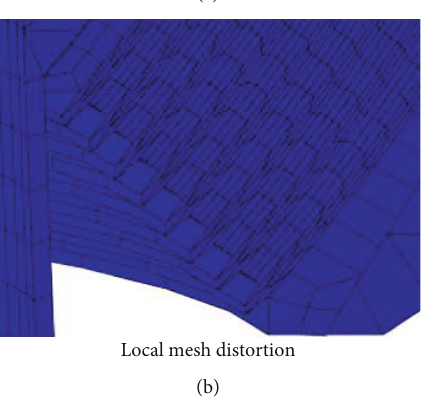
Figure 6: Calculated deformation